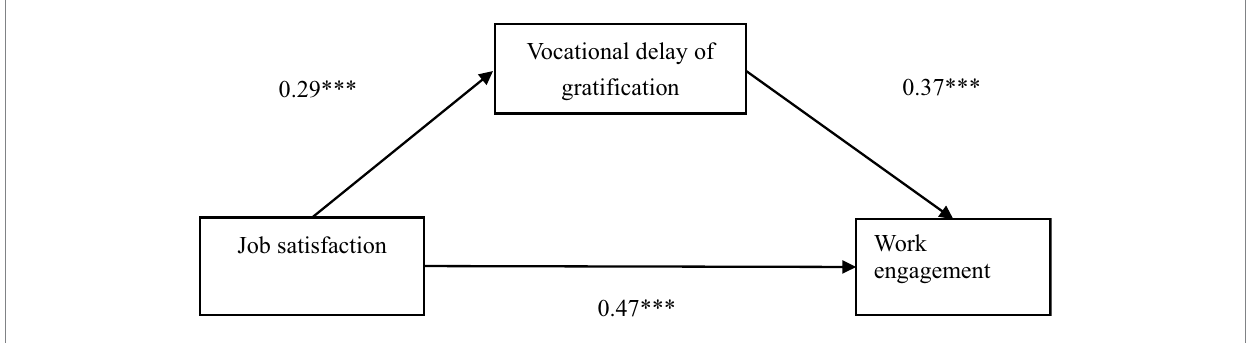
FIGURE 1 The medication model of vocational delay of gratification on the relationship between job satisfaction and work engagement. *** p <